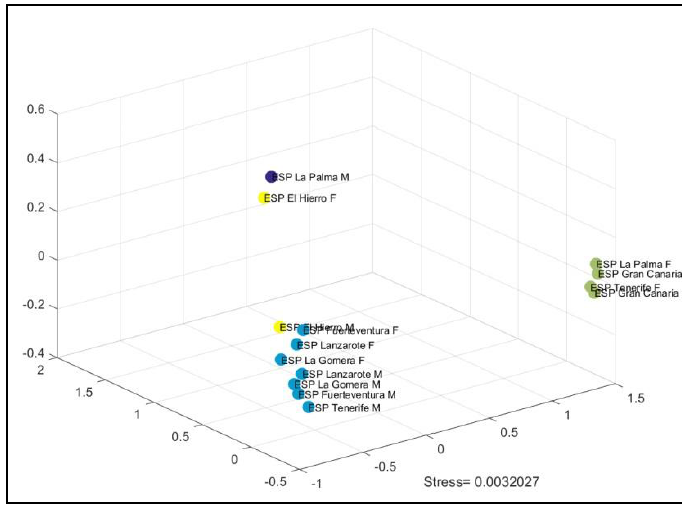
Figure 14. Three-dimensional MDS of SVO + Exp interrogative sentences with the value of Stress.